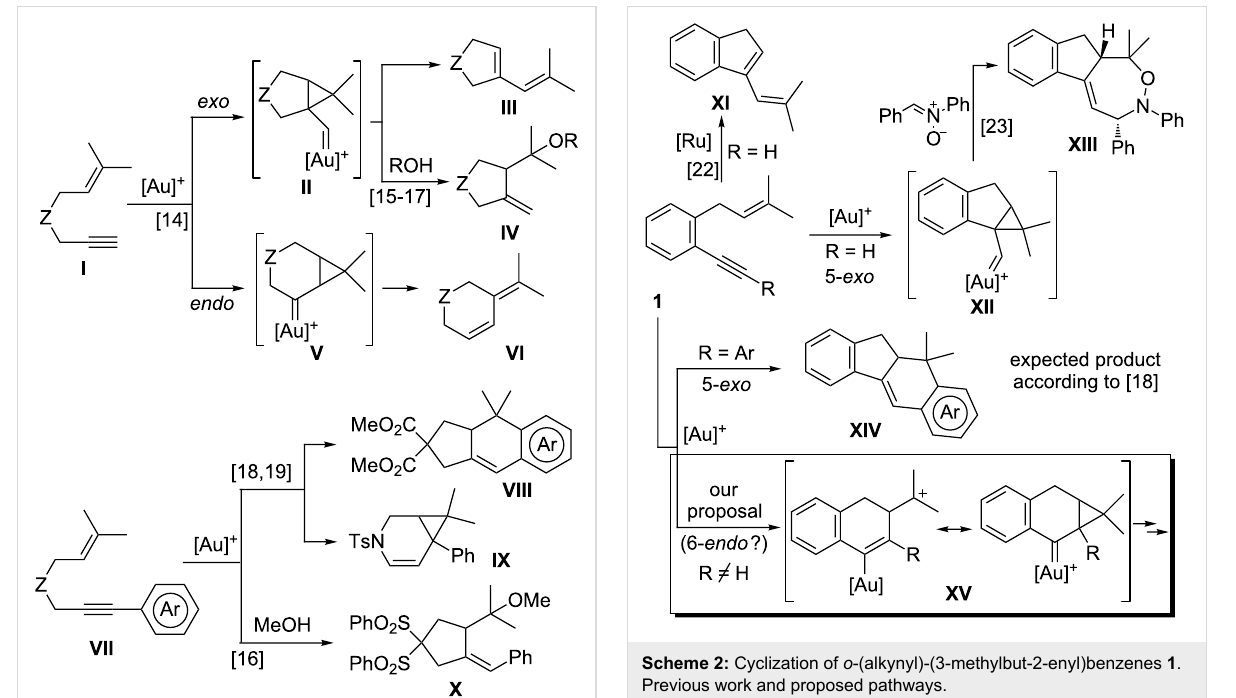
nyl-1,6-enynes with a terminal double bond gives rise to bi- cyclo[3.2.0]heptene derivatives